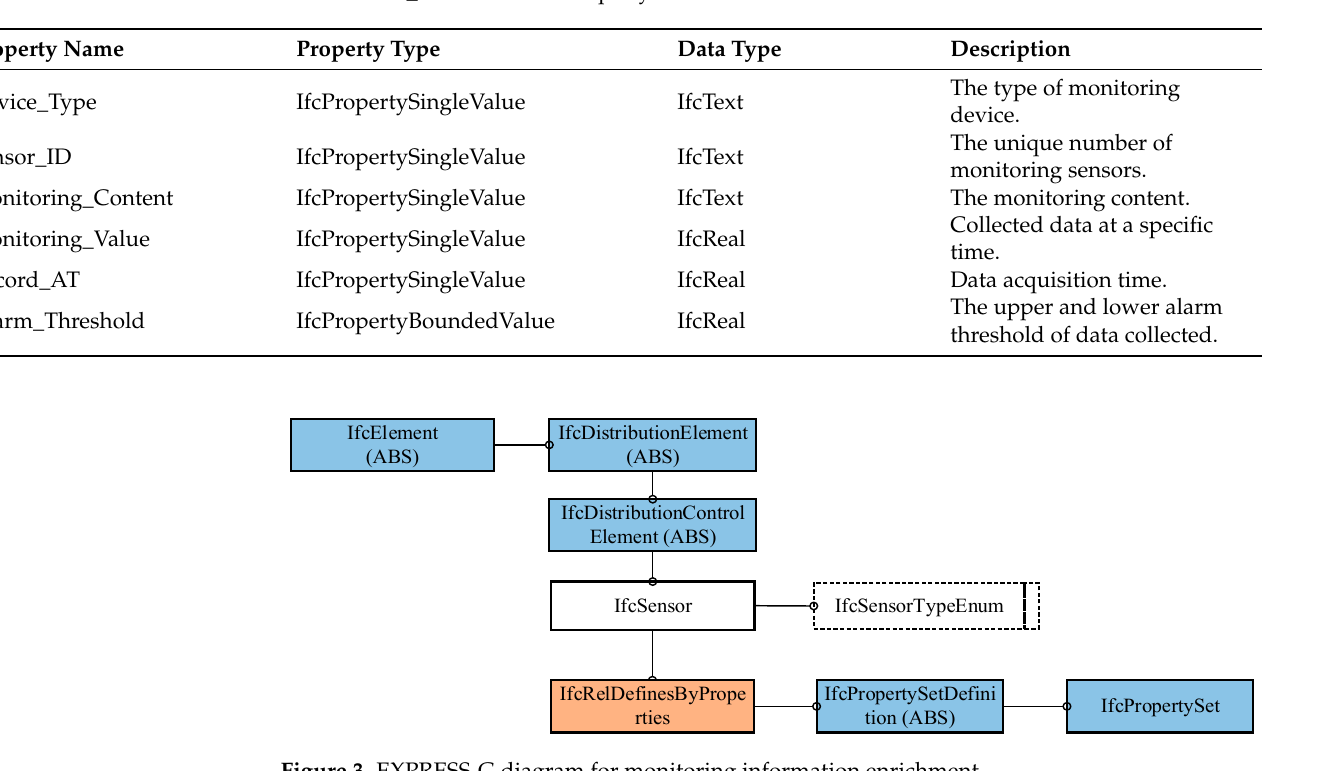
Table 1. Pset_SensorFeature Property Set Definition. Table 2. Pset_SensorFeature Property Definition.